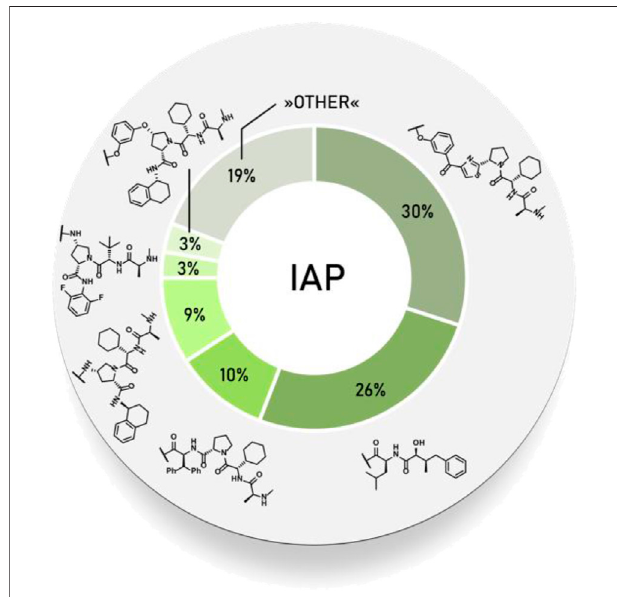
FIGURE 7 | Frequency of IAP ligands used in PROTAC compounds.